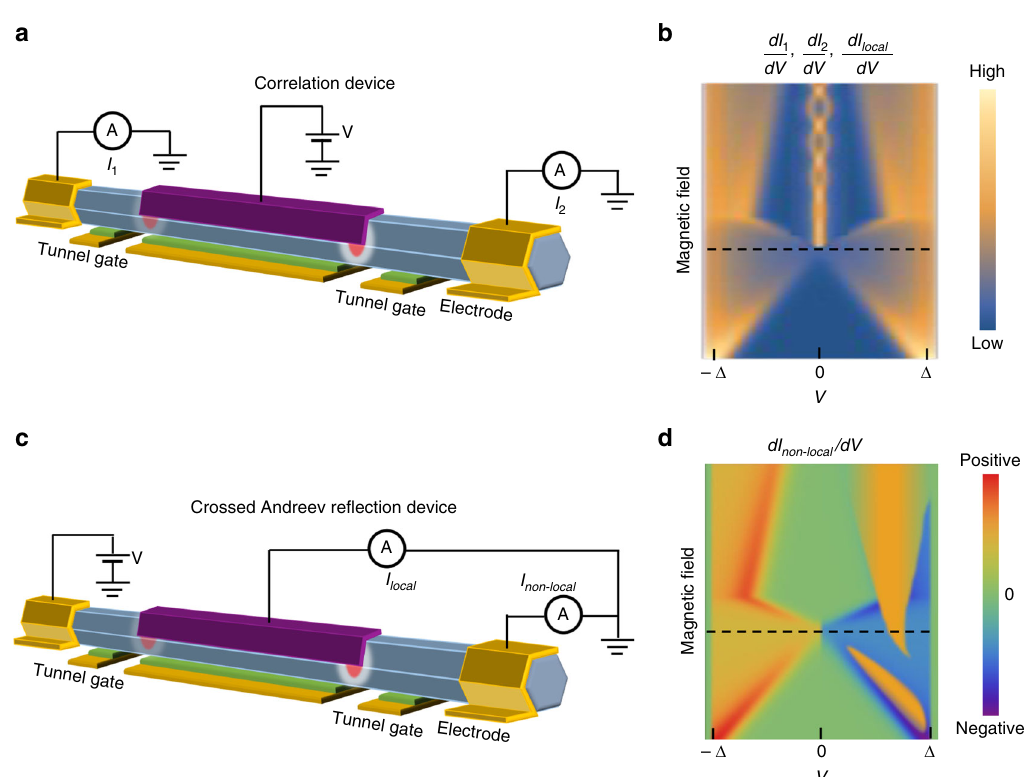
Fig. 3 Majorana correlation and crossed Andreev re fl ection devices. a Schematic experimental setup of a Majorana correlation device to measure the currents I 1 and I 2 from the two ends, separately. c Crossed Andreev re fl ection device to measure the local and non-local currents I local and I non – local . b Schematic plot of dI 1 / dV , dI 2 / dV , and dI local / dV indicate the correlated ZBP and its splitting in the correlation device and crossed Andreev re fl ection device. d Schematic plot of dI non − local / dV can capture the topological phase transition as an odd function of bias with negative non-local conductance on one side. The black dashed line indicates the topological transition, consistent with the local